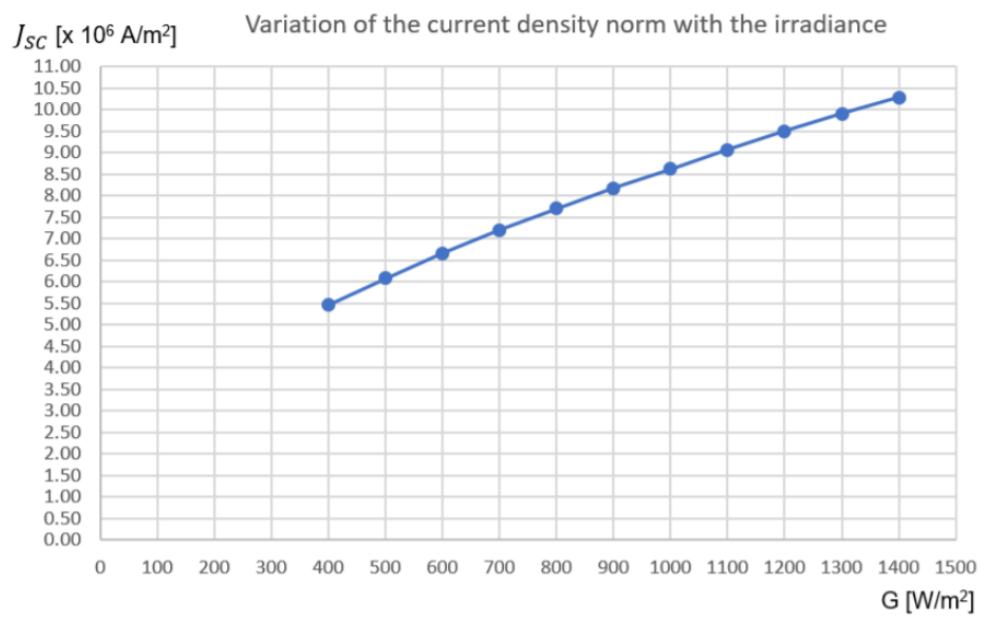
Figure 23. 1D Plot of the variation of J sc with the irradiance ( x -axis: Irradiance [W/m2]; y -axis: Average value of the current density norm, J sc